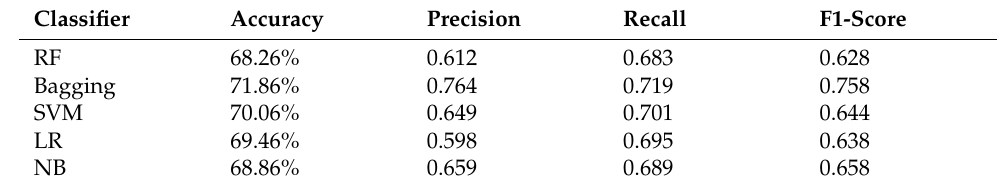
Table 19. Experiments with ML models and the AFFIN lexicon on the TextBlob sentiments.